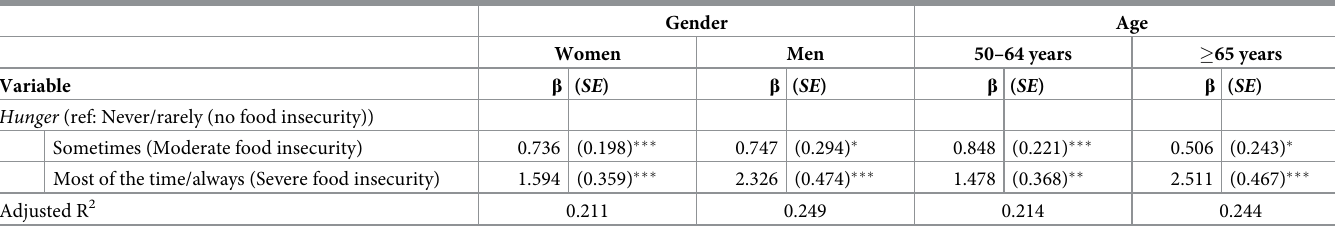
Table 3. The associations between food insecurity with hunger and psychological distress score (10–50): Multivariate gender- and age-based linear